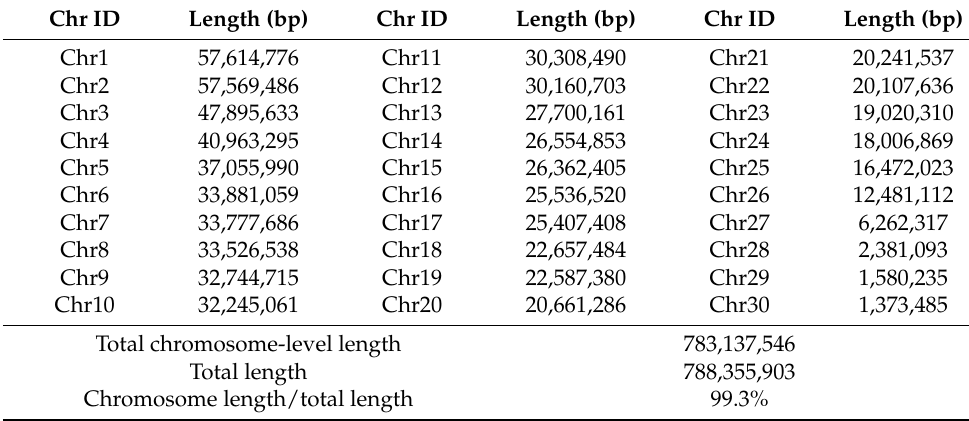
Table 3. Statistics of chromosomal level assembly of striped